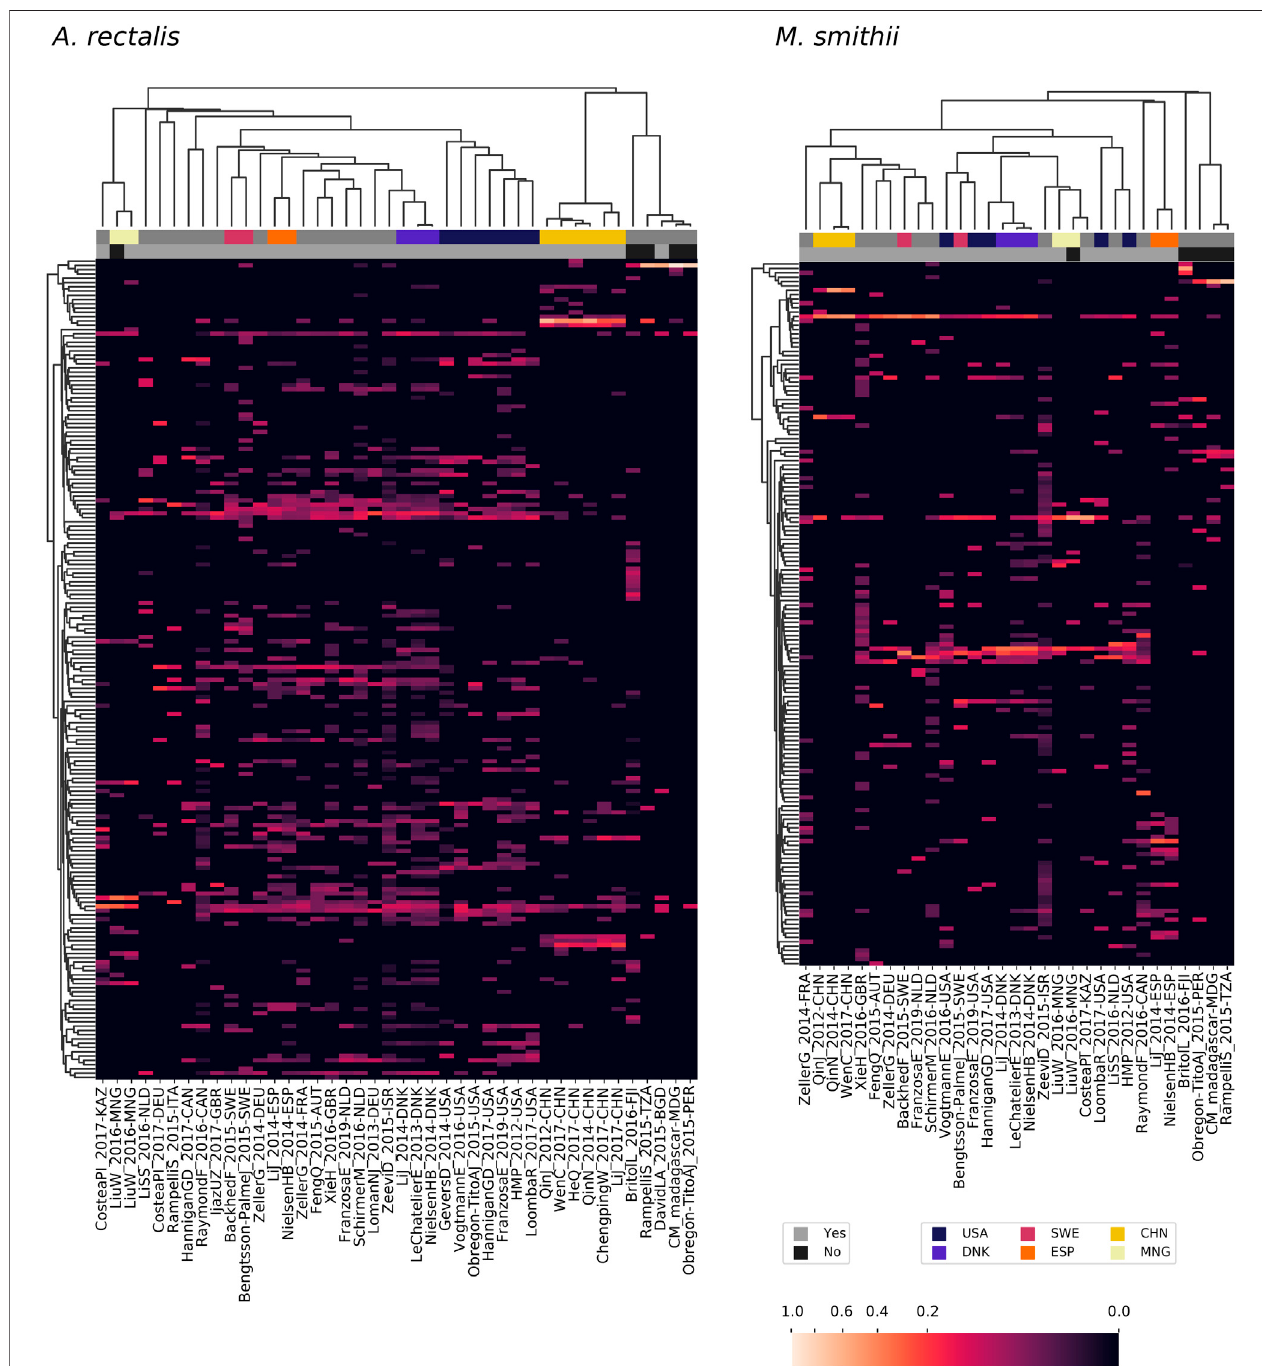
FIGURE 5 | Patterns in strain dominance according to geography and lifestyle across thousands of publicly available metagenomes in dozens of independent studies for two common members of the human gut microbiome. Columns represent collections of samples from individual studies and are further segmented by country and lifestyle (westernized or not). Rows represent strains inferred by StrainFacts. Cell colors re fl ect the fraction of samples in that study segment with that strain as the most abundant member. Study segments are omitted if they include fewer than 10 samples. Row ordering and the associated dendrogram re fl ect strain genotype distances, while the dendrogram for columns is based on their cosine similarity. Studies with samples collected in several countries with notable clustering for one ormore species arehighlightedwithcolorsabovethe heatmap. Additionally,studies from westernized populationsare indicated. Bothastudyidenti fi erand theISO 3166-ISO country-code are included in the column